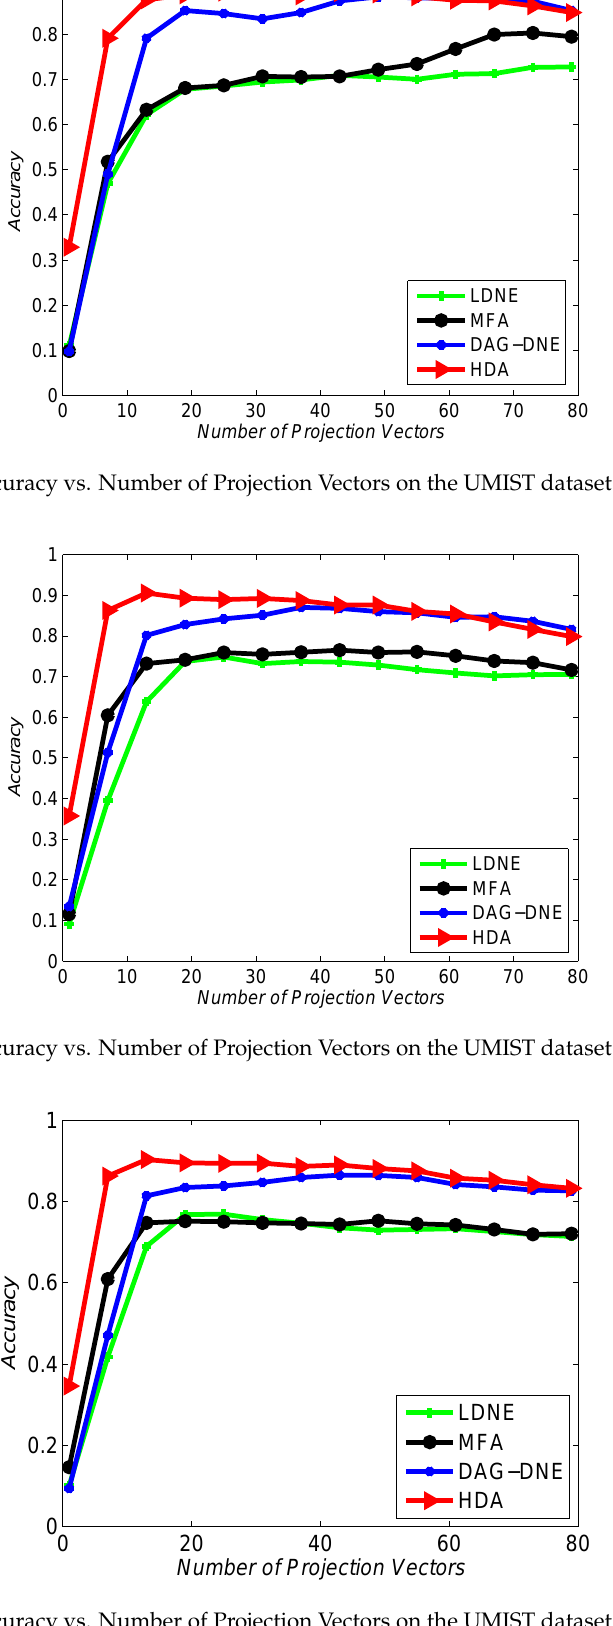
Figure 9. Accuracy vs. Number of Projection Vectors on the UMIST dataset under K =